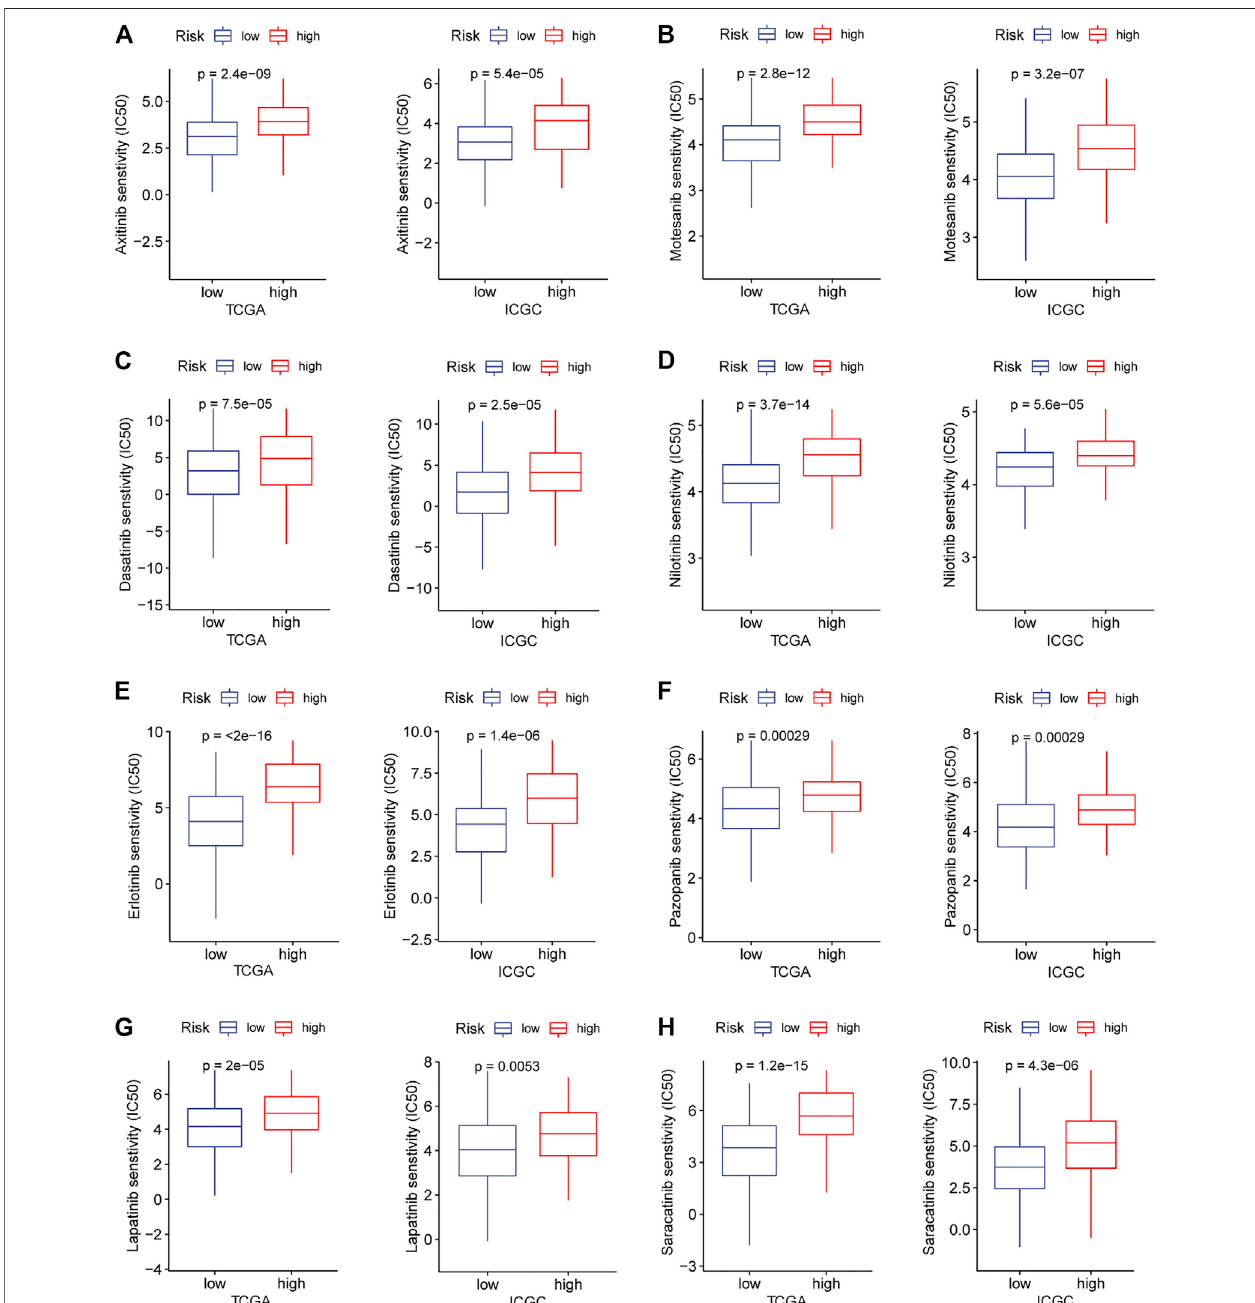
FIGURE 6 | In the TARGET and ICGC cohorts, high and low-risk patients and targeted drug sensitivity. (A) Axitinib (B) Motesanib (C) Dasatinib (D) Nilotinib (E) Erlotinib (F) Pazopanib (G) Lapatinib (H) Saracatinib.